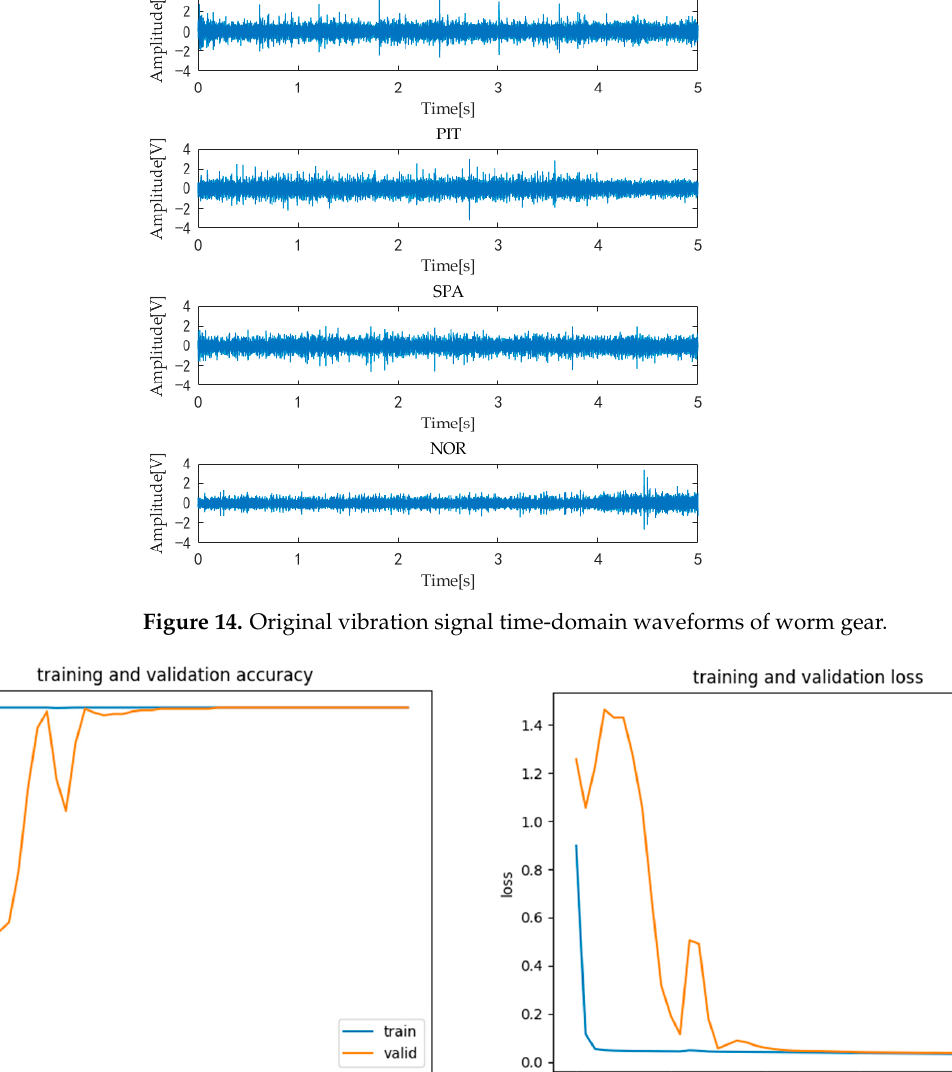
Figure 15. ( a ) Accuracy of the SR − 1DCNN model; ( b ) Loss of the SR − 1DCNN model.